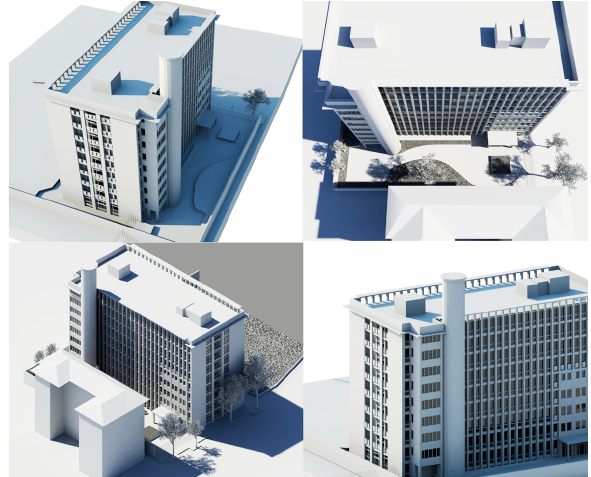
Figure 9. Building for offices (1949) in Milan, Italy (architect P. Lingeri). Reconstructed CH by Smooth Shaded Triangular Mesh and Vertex Painted Medium Quality Triangular